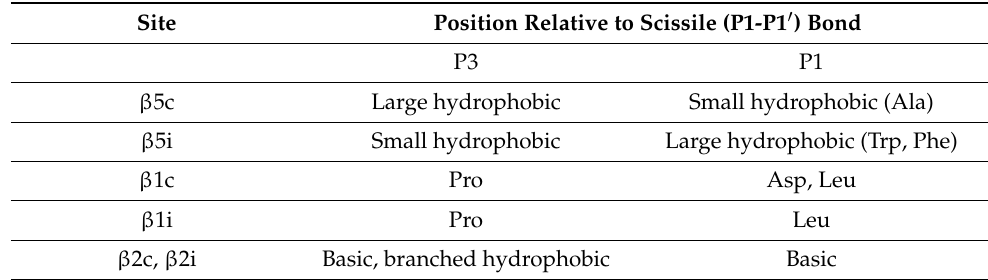
Table 2. Key specificity features of proteasome subunits used to design inhibitors. Site